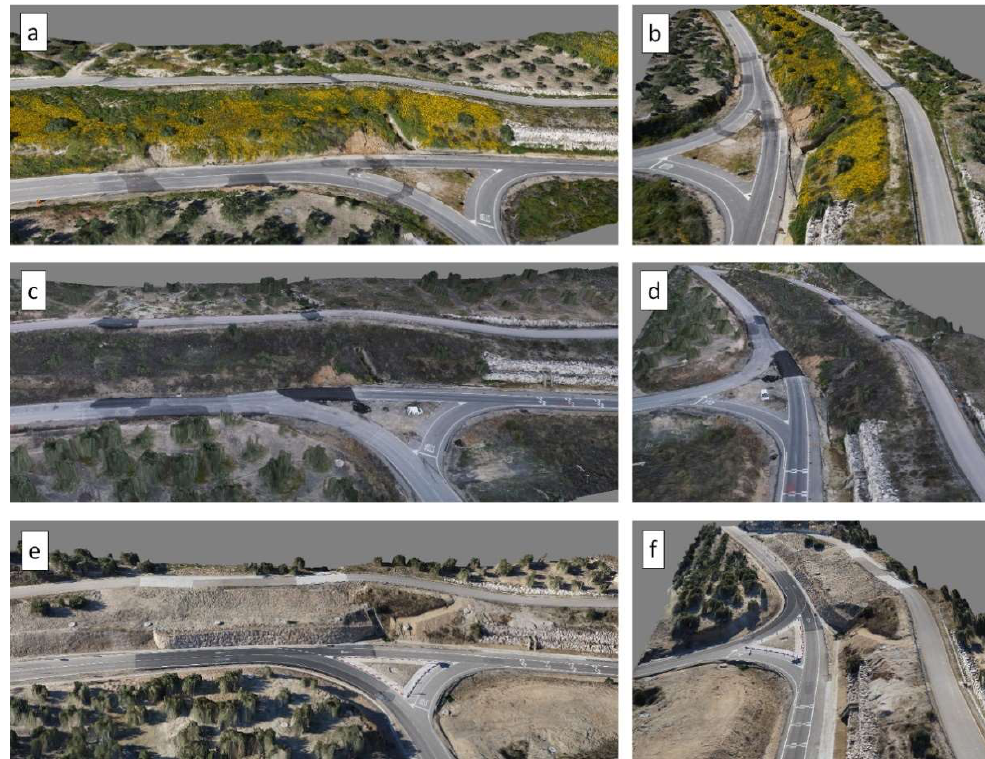
Figure 2. ( a ) Photorealistic reconstructions of the landslide foot with the roads affected: ( a ): 24 April 2013 frontal view; ( b ): 24 April 2013 lateral view; ( c ): 5 March 2014 frontal view; ( d ): 5 March 2014 lateral view; ( e ) 19 November 2015 frontal view; ( f ): 19 November 2015 lateral view (it can be observed the drainage wells and the retaining wall).